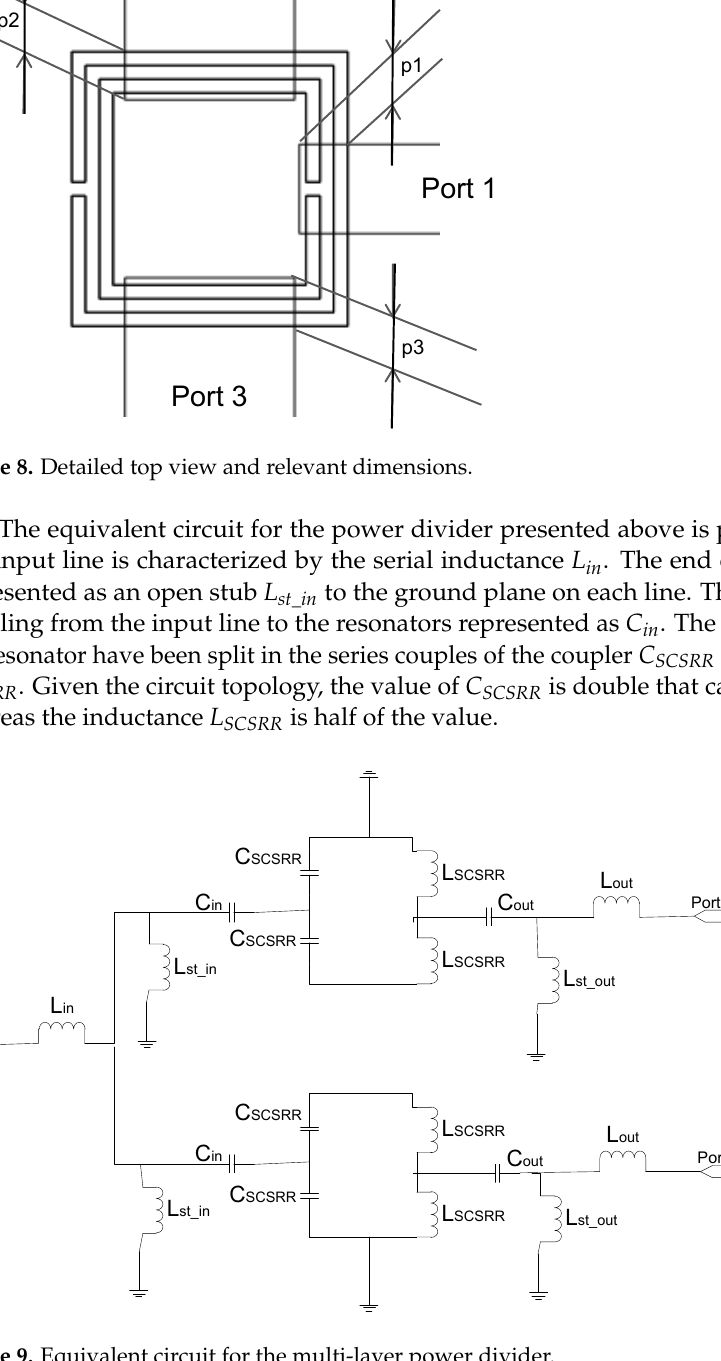
( b ) Figure 7. ( a ) Top view of the SCSRR within the power divider. ( b ) Front view of the device. The stripline, which acts as the input, is cut as an opened stub. Both SCSRRs are placed exactly in the same position in top and bottom of this input line. The line is in-